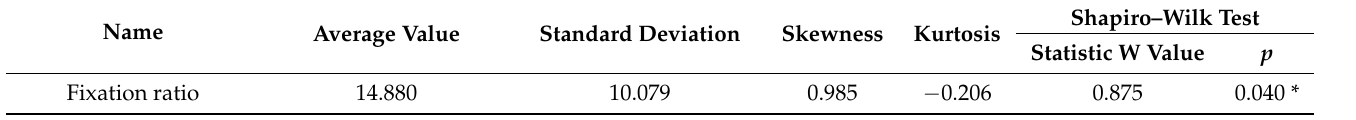
Table 29. Data normality test for the proportion of button fixation points with different